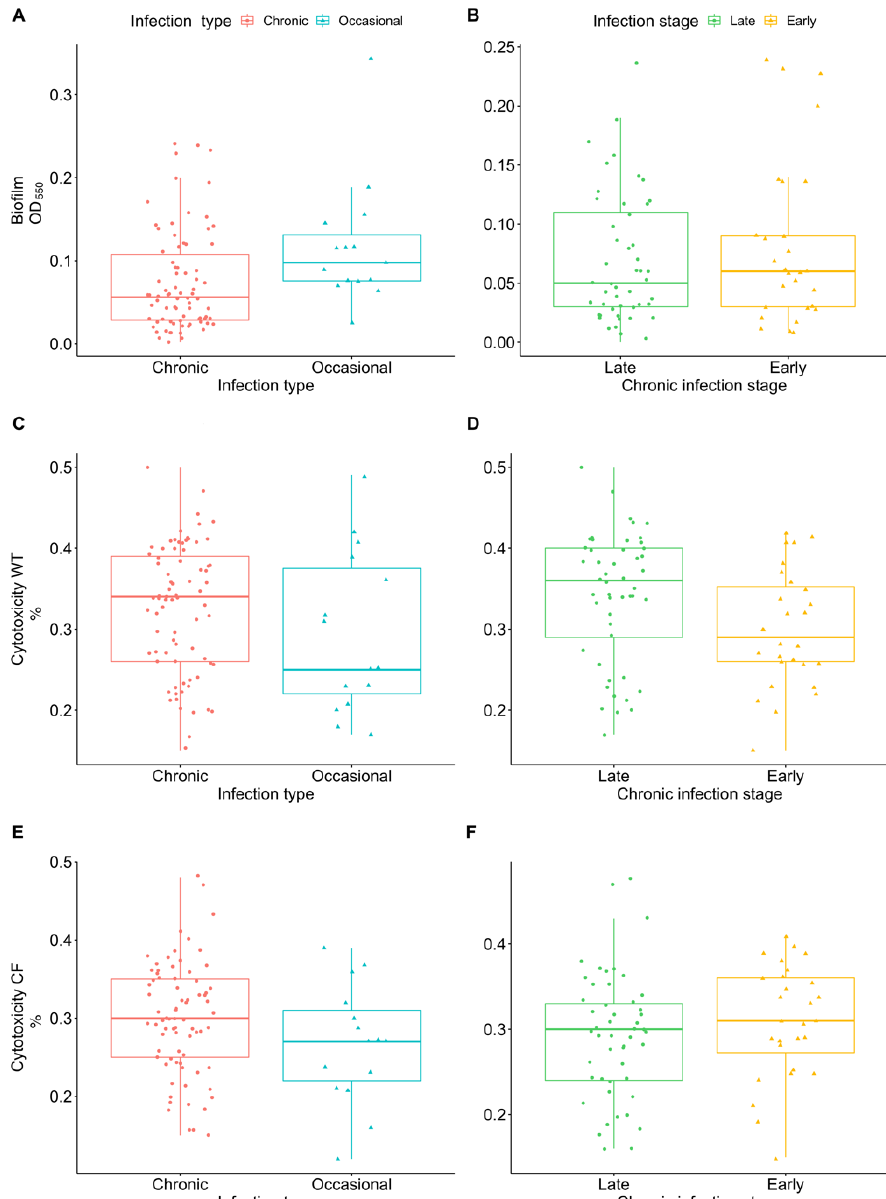
Figure 2. Achromobacter spp. biofilm formation and cytotoxicity on WT and CF bronchial epithelial cells. Biofilm formation in occasional and chronic isolates ( A ) and in early and late chronic isolates ( B ) measured by crystal violet staining (OD 550 ). Cytotoxicity of occasional and chronic isolates and of early and late chronic isolates on WT cells ( C , D ) and CF cells ( E , F ) expressed as percentage of LDH release compared to the maximum value (positive control).